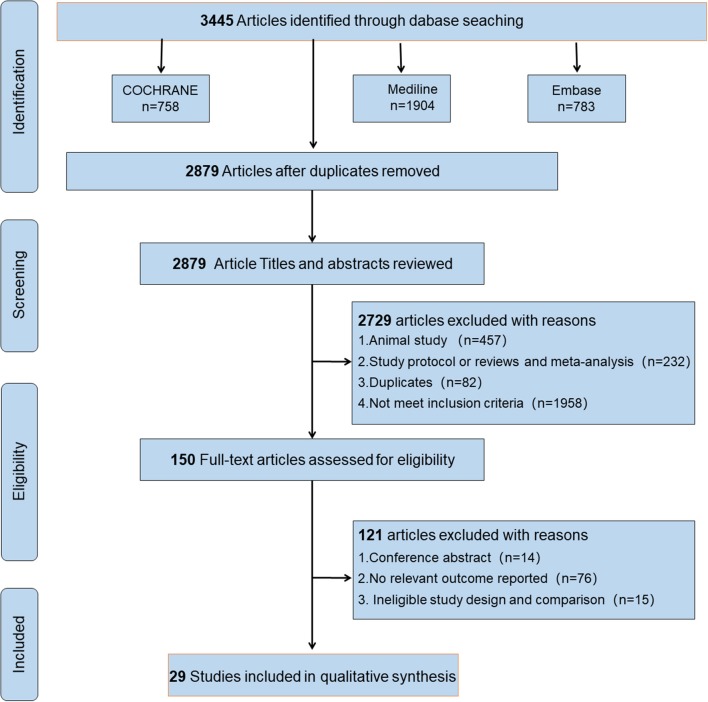
Flow diagram of studies identified, included, and excluded.